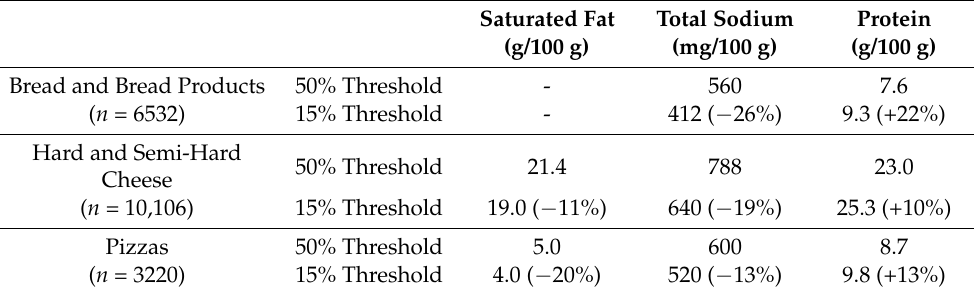
Table 2. The 50% and 15% nutrient thresholds for “Bread and Bread Products”, “Hard and Semi-Hard Cheese”, and “Pizza” (with relative difference between the two thresholds in brackets). Saturated Fat Total Sodium Protein (g/100 g) (mg/100 g) (g/100 g) Bread and Bread Products 50% Threshold - 560 ( n = 6532) Hard and Semi-Hard 50% Cheese